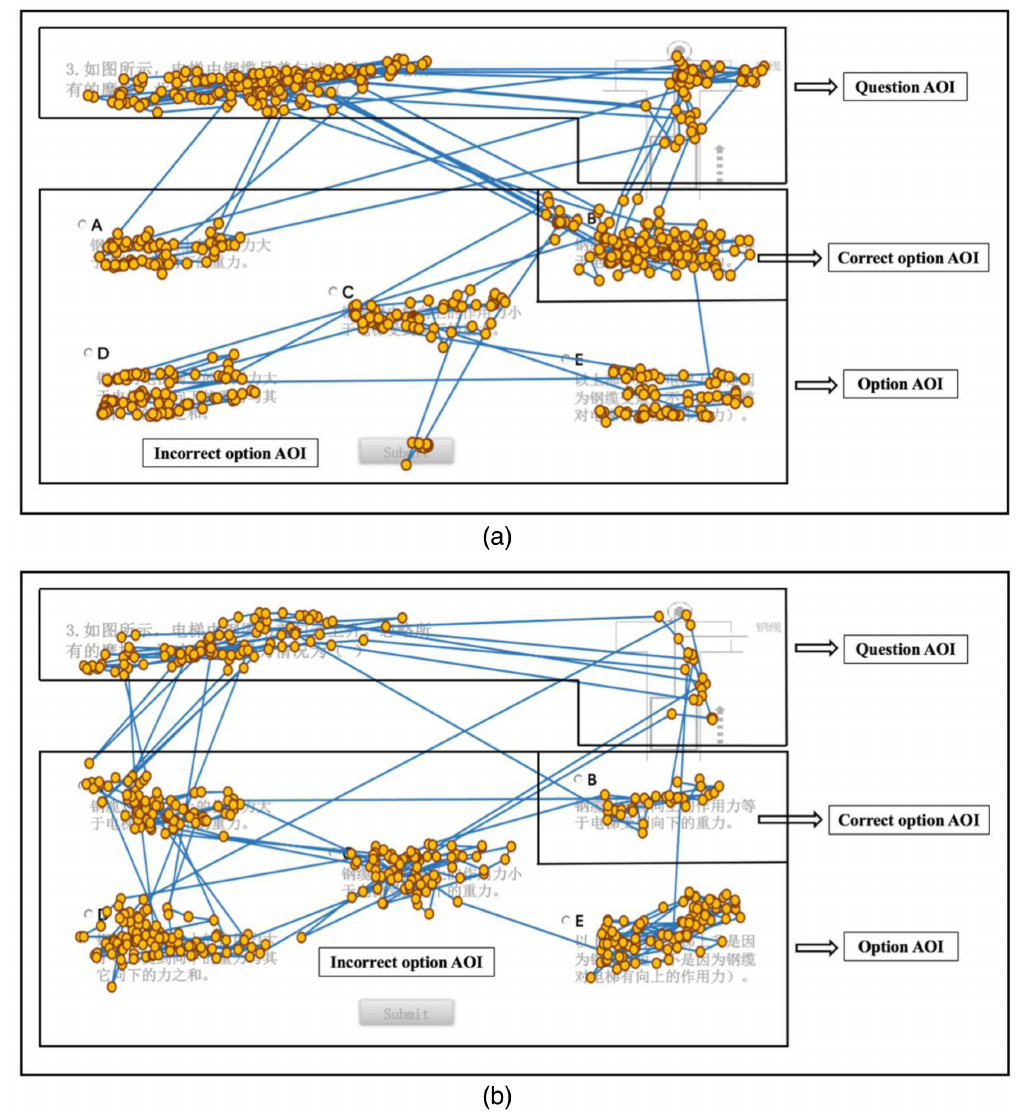
FIG. 3. (a) The scan path of participant C with positive prediction when solving item 3 (FCI question 17 [69]). (b) The scan path of participant D with negative prediction when solving item 3 (FCI question 17 [69]). Circles and solid lines represent the fixations and